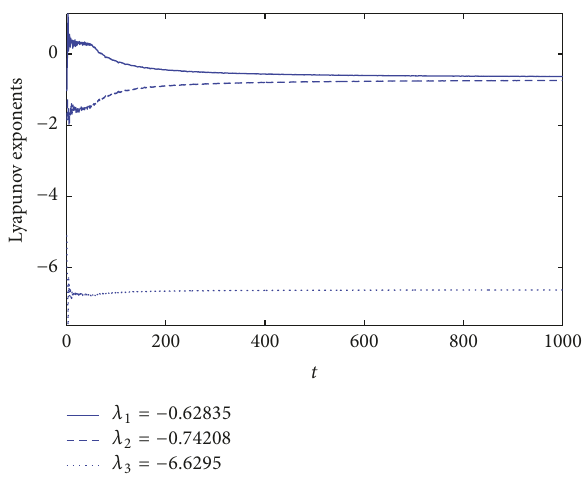
Figure 5: The dynamics of the problem’s Lyapunov exponents for 𝛼 = 5 , 𝑅 = 25 , 𝜎 1 = 4.5 , and 𝜂 = 6